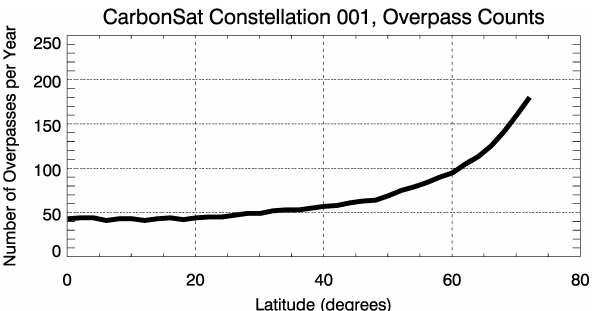
Fig. 4. Approximate number of overpasses per year over a target as a function of latitude. Power plants in the mid latitudes will have about 50 overpasses per year for a 1-CarbonSat scenario (configura- tion 001). Clear sky probability obtained from MODIS can be used to provide an approximation of the cloud free measurements over a target (see Fig. 5).